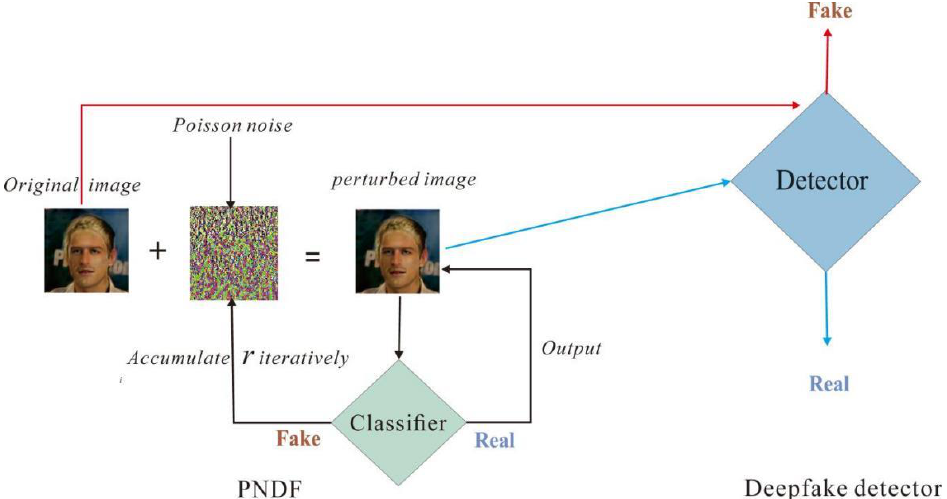
Figure 4. Schematic diagram of modifying the image reversely to deceive the detector. On the left is the process of using PNDF to iteratively add a perturbation r to the original image. Poisson noise is added when r is updated to obtain the perturbation in different directions. When the label obtained by the classifier changes, the perturbed image is outputted as the detector ’ s input to make the detector’s judgment result opposite to the original image.